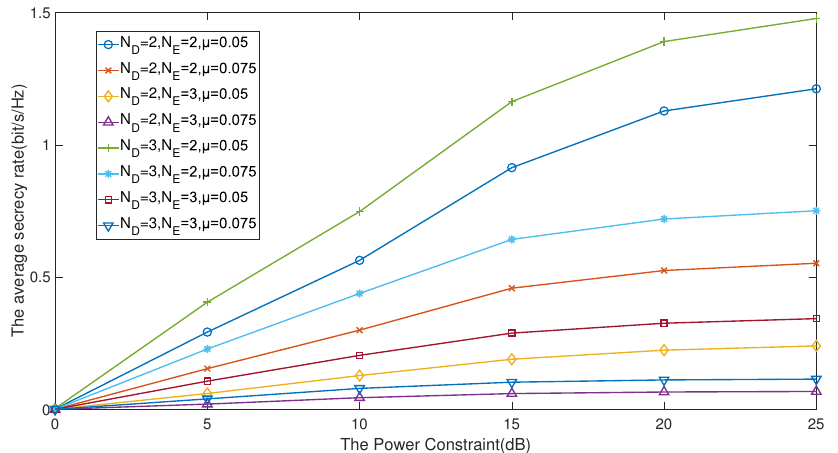
Figure 3. Average secrecy rate versus power constraint, a comparison of different antenna numbers and CSI